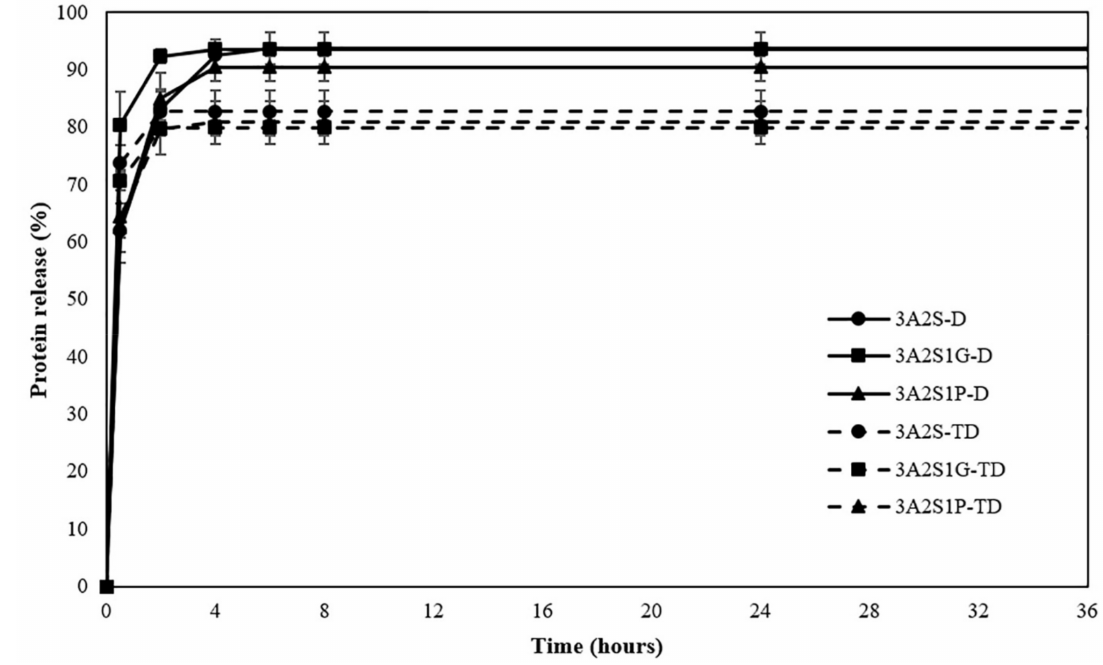
Figure 3. Protein release of scaffolds (3A2S, 3A2S1G, 3A2S1P) that were prepared by the freeze-drying method (D) (solid line) and by freeze-thawing together with the freeze-drying method (TD) (dashed